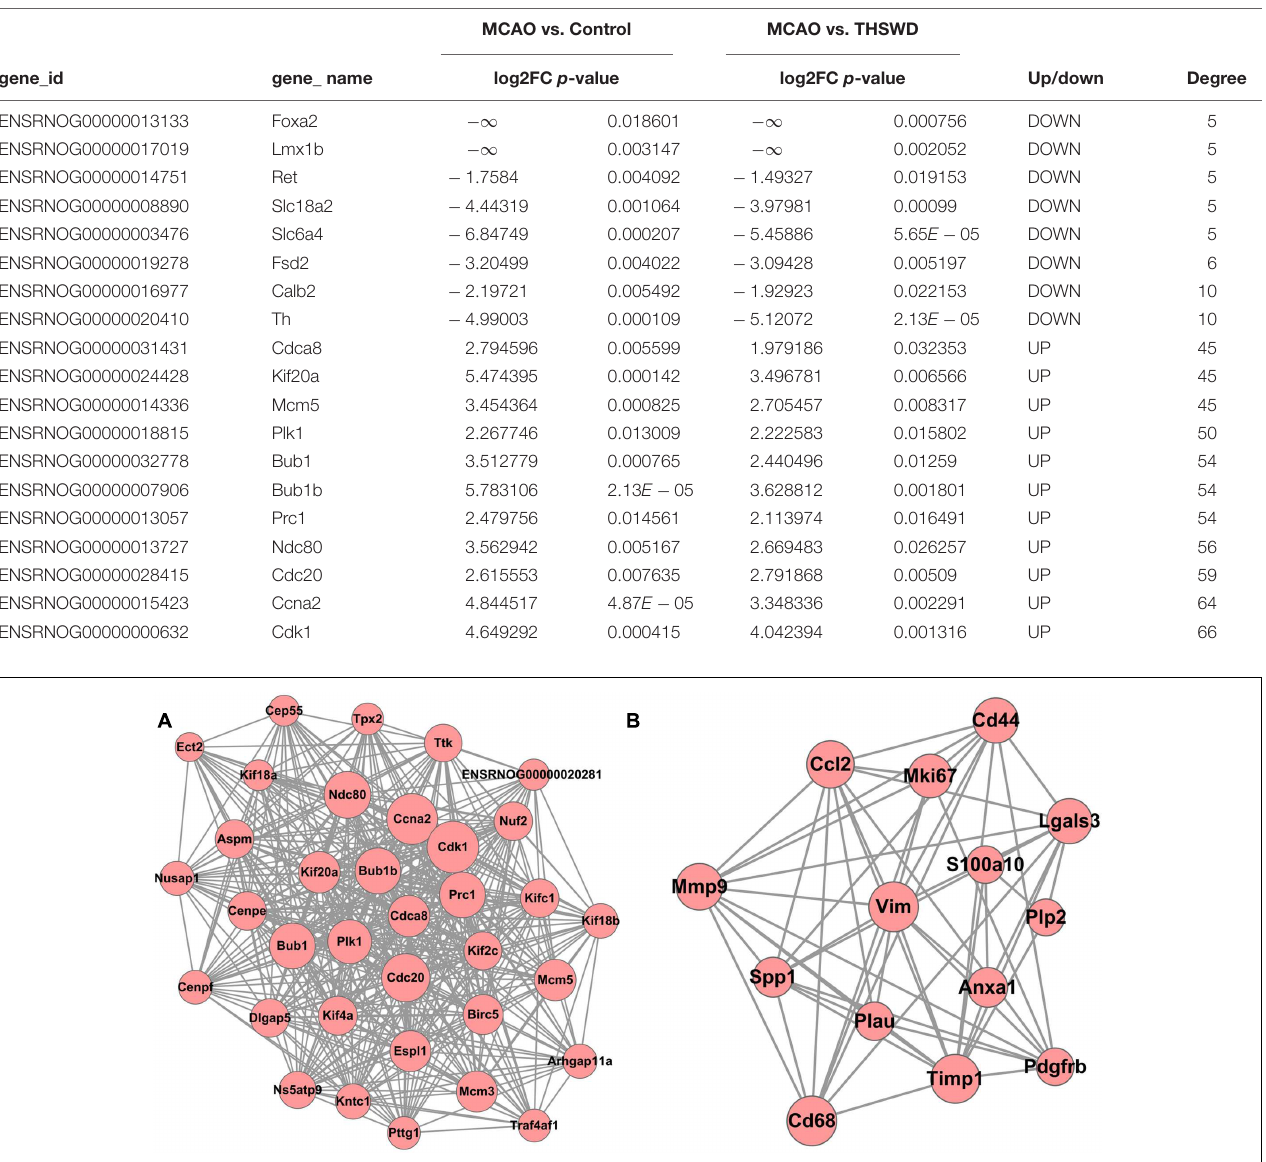
TABLE 2 | Top10 degrees of up- and down-regulated genes (node degree ≥ 5). MCAO vs. Control MCAO vs. THSWD